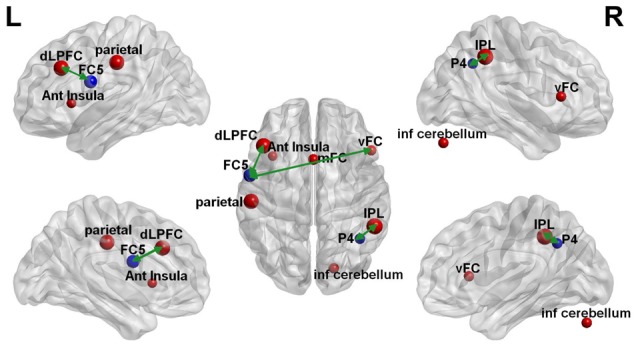
Multi-modal EEG-fMRI graph depicted on a brain surface model. The clustering coefficient of the brain regions that revealed significant changes with rTMS on EEG (blue sphere) and rsfMRI (red sphere) is illustrated proportionate to their effect sizes. The green double edge arrows reveal areas that had significant correlations on EEG and rsfMRI.